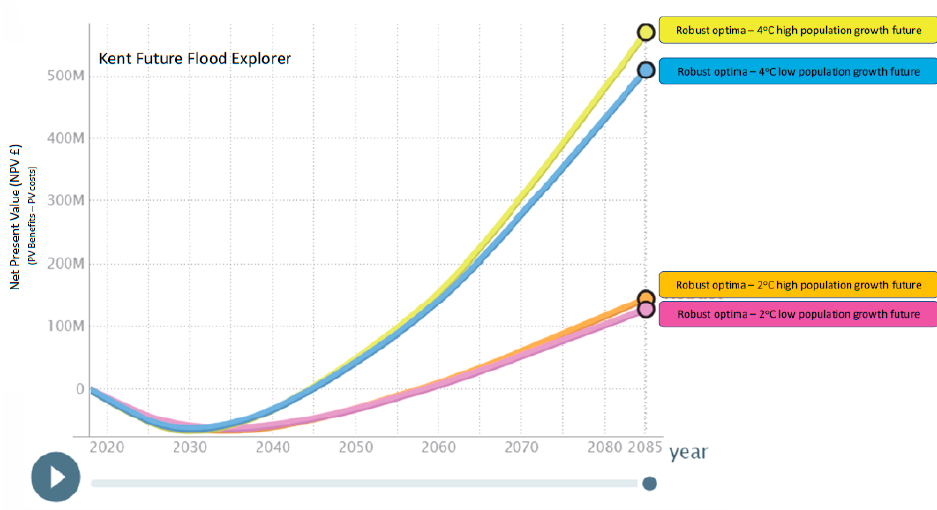
Figure 6. Robust optimisation of alternative flood risk management adaptation portfolios in Kent using the Kent Future Flood Explorer. Note: An optimisation of the net present value through to 2085 based on the identification of the adaptation portfolios delivering the greatest minimum NPV across all alternative futures.